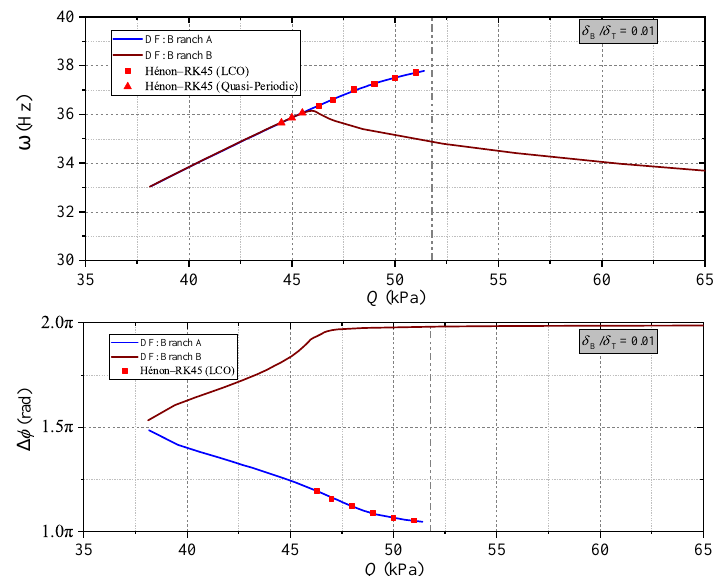
Figure 14. LCO frequency and phase-difference variations with dynamic pressure at δ B / δ T = 0.01.